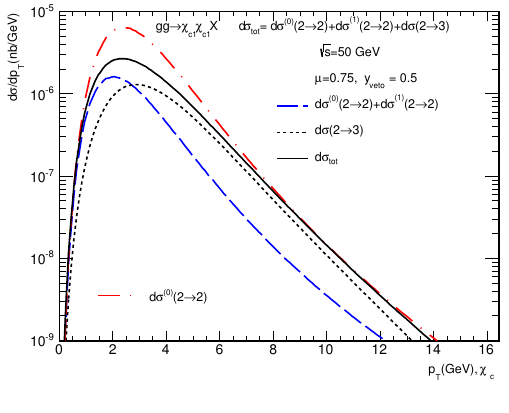
Figure 3. Di ff erential cross section as a function of χ c 1 transverse momentum when the second produced particle is χ c 1 . The dotted-dashed (red) line is for leading order